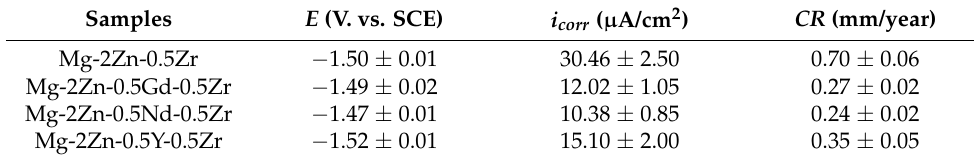
Table 6. Tafel fitting results of the potentiodynamic polarization curves of the alloys.